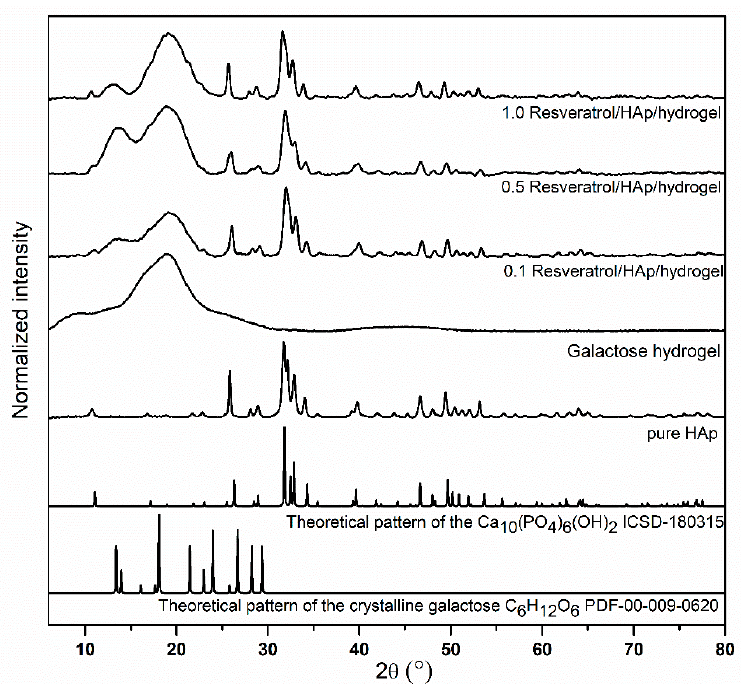
Figure 3. XRD spectra of hydroxyapatite, 3,6-anhydro- α -L-galacto- β -D-galactan and galactose hydrogels filled with resveratrol, at concentrations of 0.1, 0.5, and 1.0 mM, and at 1 mM concentration of hydroxyapatite.